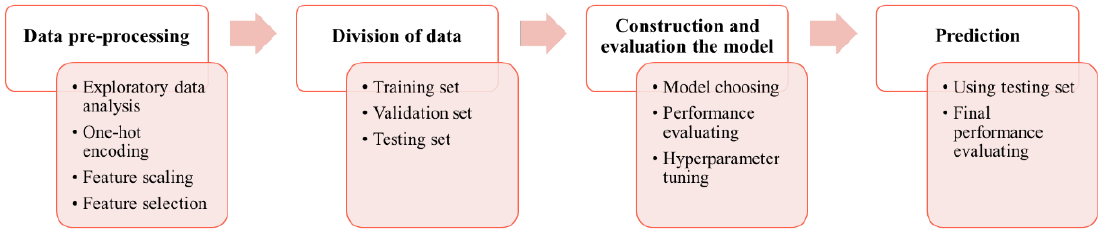
Figure 8. Process of machine learning. Table 6. Description of used libraries.